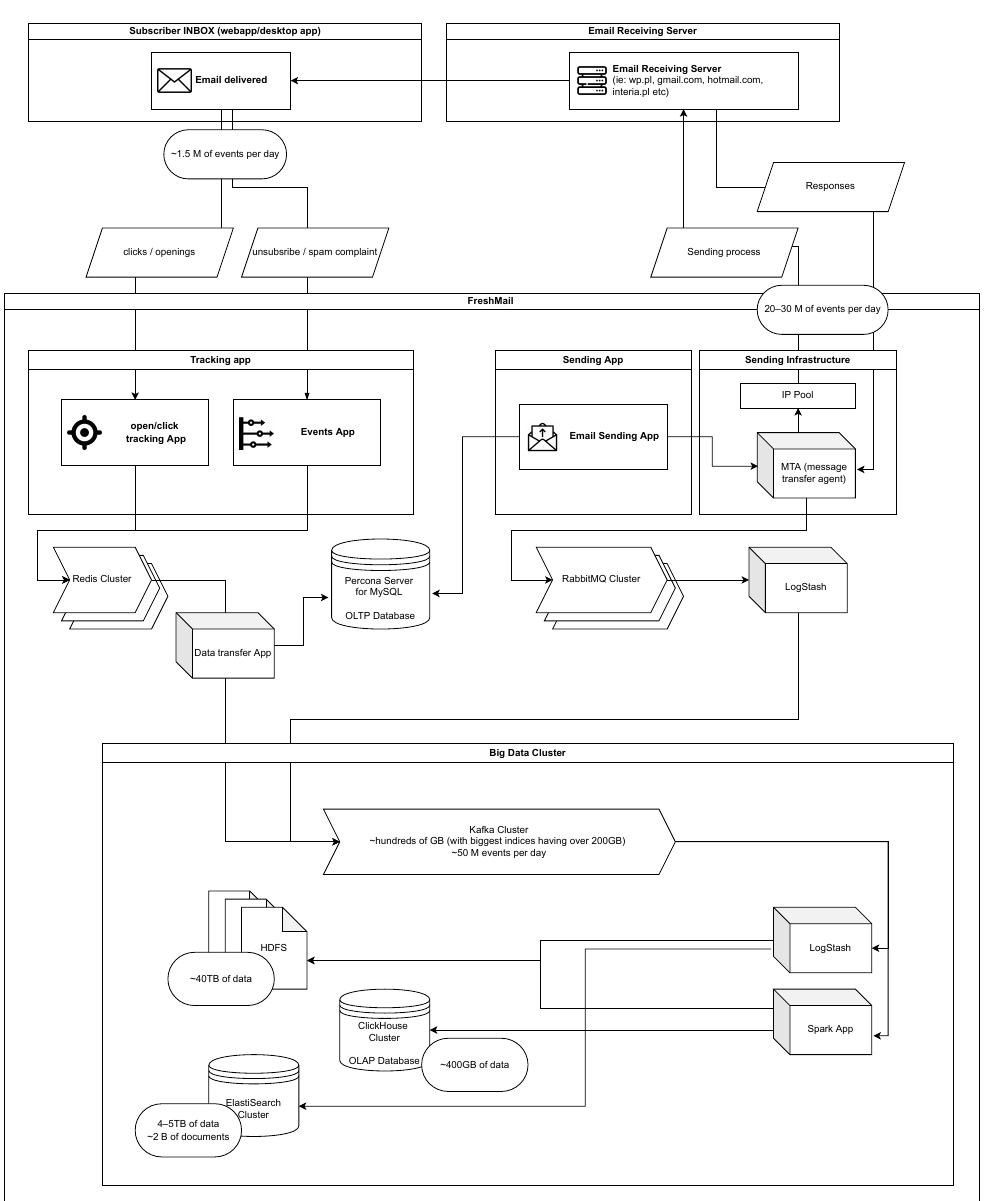
Figure 1. Freshmail data processing